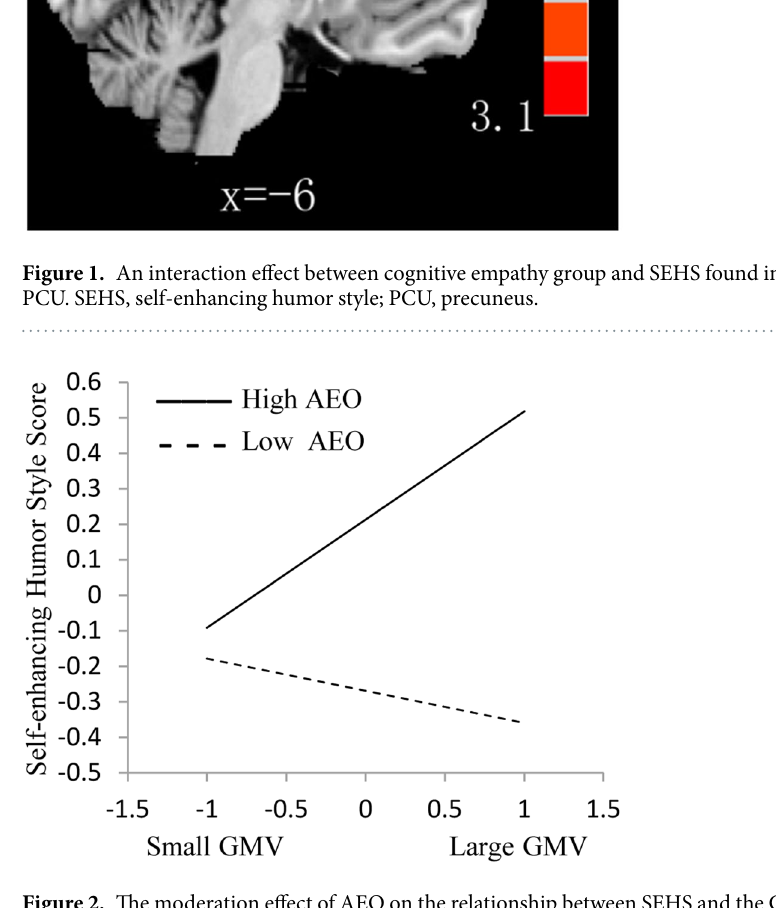
Figure 2. The moderation effect of AEO on the relationship between SEHS and the GMV of PCU. The x-axis represents standardized scores of the GMV of PCU and the y-axis represents standardized SEHS scores. The solid line indicates the high AEO group and the dashed line indicates the low AEO group. AEO, appraisal of the emotion of other; SEHS, self-enhancing humor style; GMV, gray matter volume; PCU,